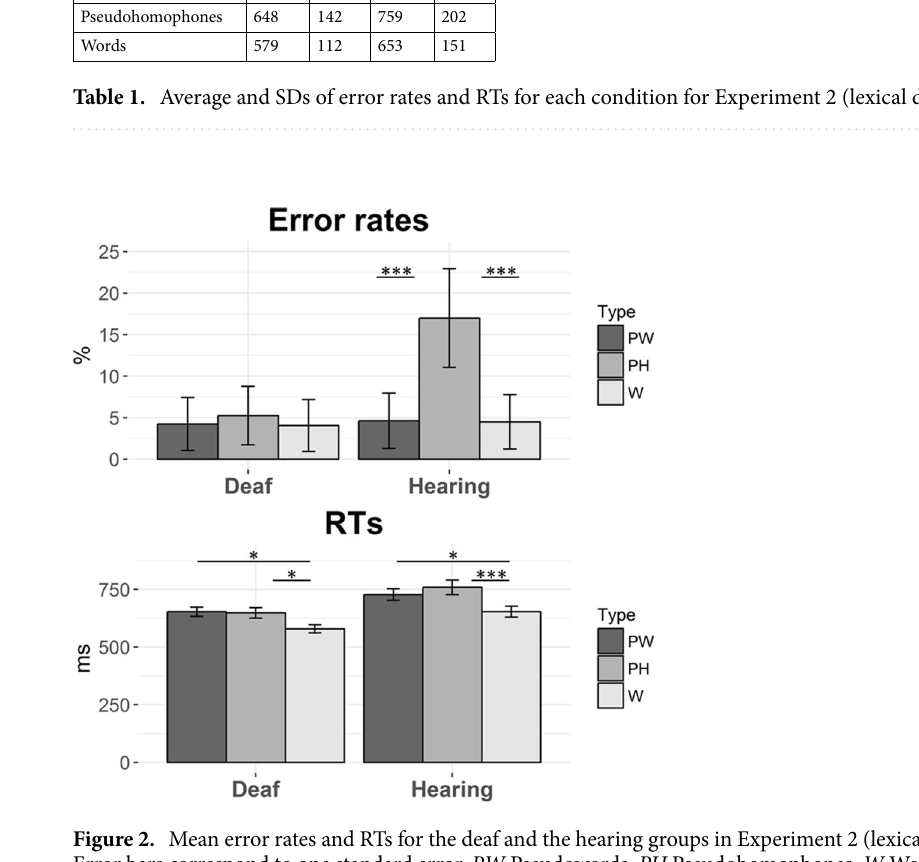
Figure 2. Mean error rates and RTs for the deaf and the hearing groups in Experiment 2 (lexical decision task). Error bars correspond to one standard error. PW Pseudowords, PH Pseudohomophones, W